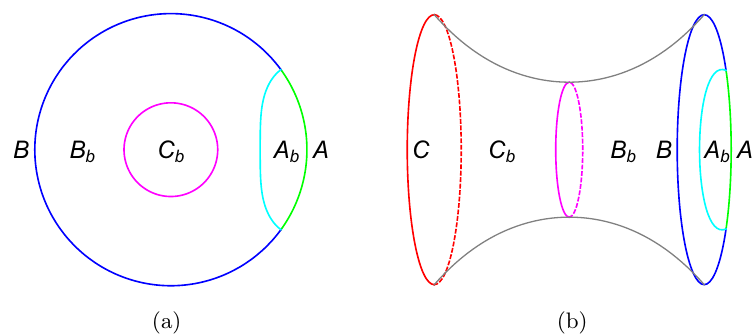
Figure 2 . Corrections to the holographic entanglement plateau. They are captured by the mutual information I ( A b ; C b ) of two disconnected bulk regions [12]. Using the AdS/CFT correspondence, they also equal the mutual information I ( A; C ) in CFT after the system is puri(cid:12)ed by adding the region C